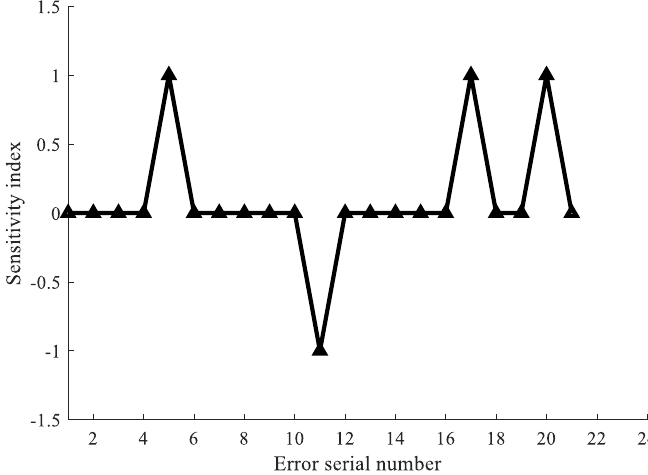
Figure 6. Sensitivity index of posture error in the x direction.